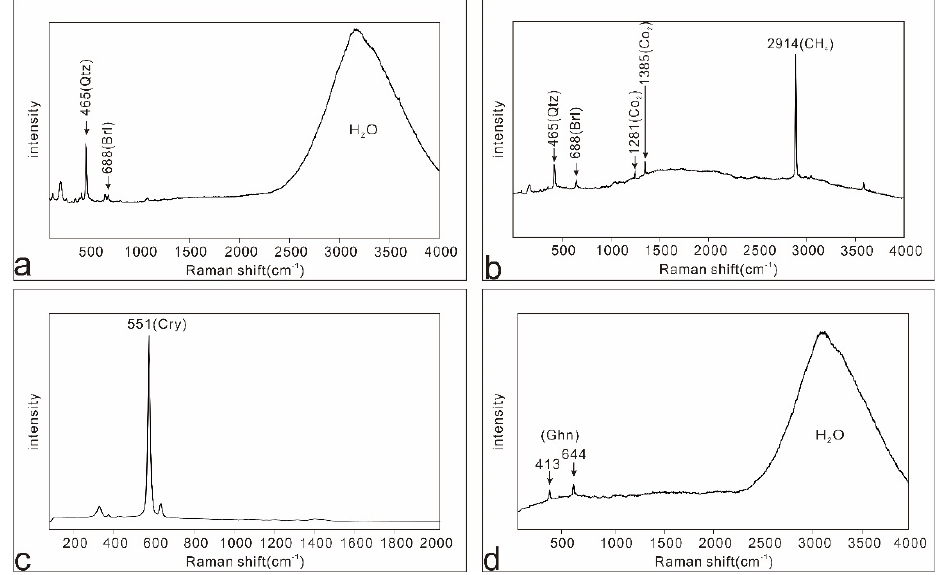
Figure 8. Raman spectra of ( a ) Solid phase, probably quartz and rich-aqueous in a melt inclusion form beryl II; ( b ) The vapor phase forms typical primary fluid inclusion hosted by beryl II contains CO2 and CH4; ( c ) Cryolite solid inclusion hosted by beryl II and quartz; ( d ) Gahnite solid inclusion hosted by beryl II.